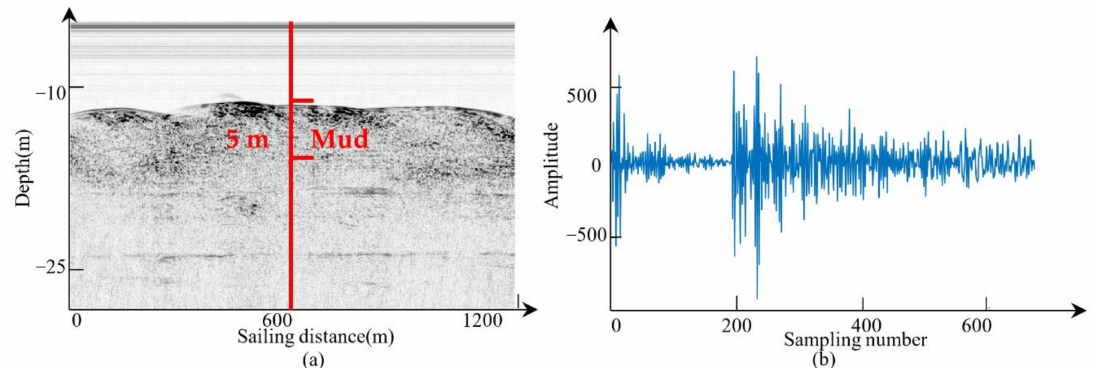
Figure 4. The measurement data. ( a ) The SBP image. ( b ) The raw data of one ping. MVMD was first applied to data of one ping. After calculating the mean and standard of each mode, the distribution characteristic of modes in the frequency domain was ana- lyzed, and the spectral overlap between two modes was assessed. The final number of modes in one ping was determined as three. Figure 5a shows the situation of the spectral overlap of decomposed modes. It can be noted that, through the proposed MVMD method, the mode u k was mostly compact around a center angular frequency ω k , and different modes were away from each other in the frequency domain. Figure 5b–d show the results of different modes.